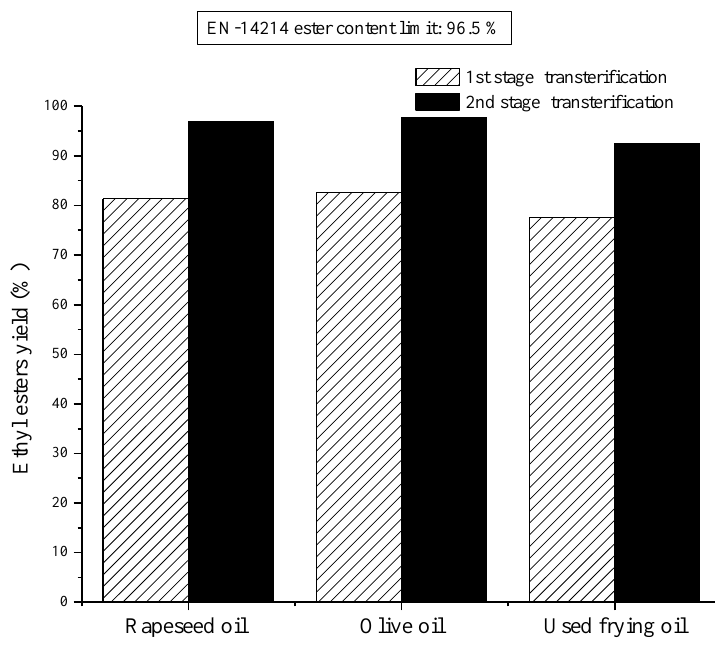
Figure 6. Two-stage transesterification of rapeseed oil, olive oil and used frying oil under optimum reaction